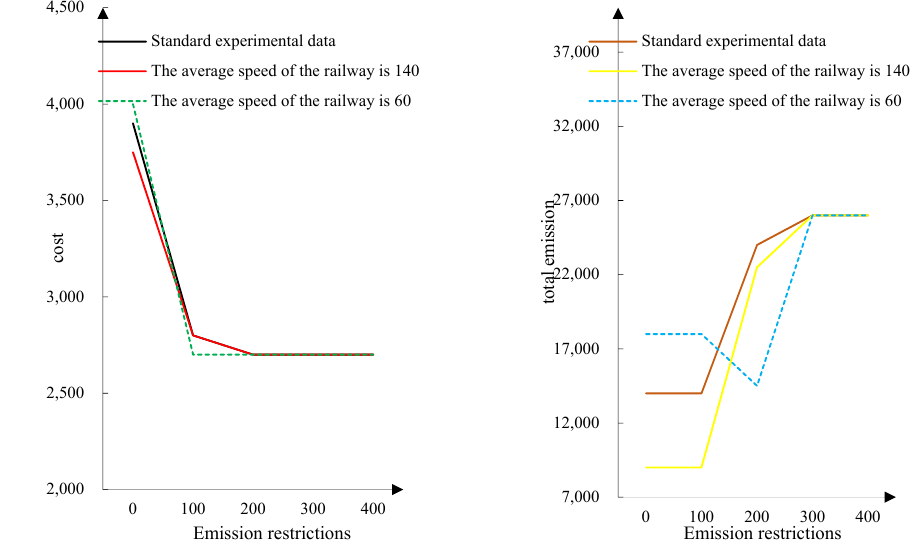
Figure 10. Effects of different railway average speed factors on route emissions.